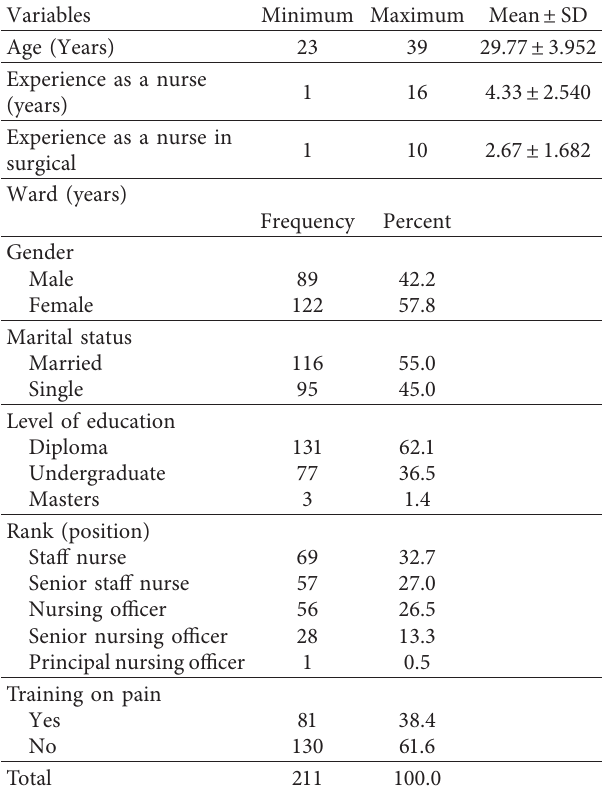
Table 1: Demographic data ( n � 211). Knowledge of pain